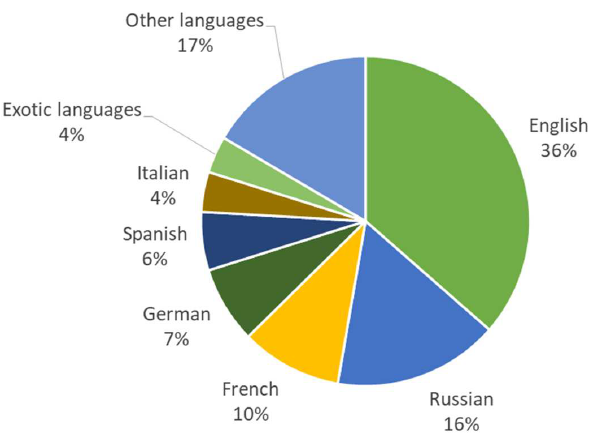
Figure 3. What languages (apart from Bulgarian) do you use in your work? N = 186.